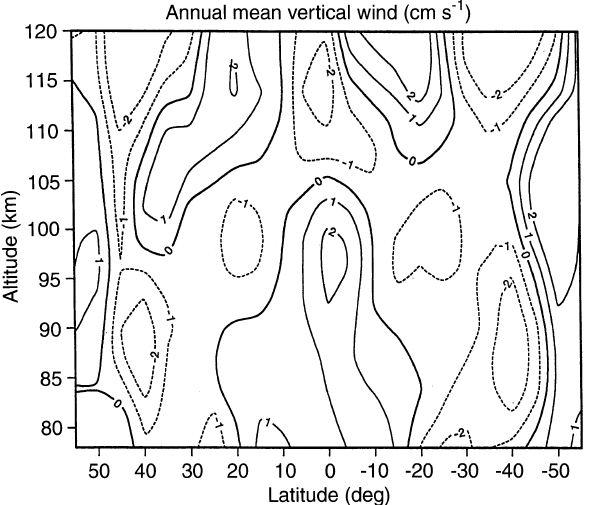
Fig. 6. Latitude-height distribution of the annual mean vertical wind